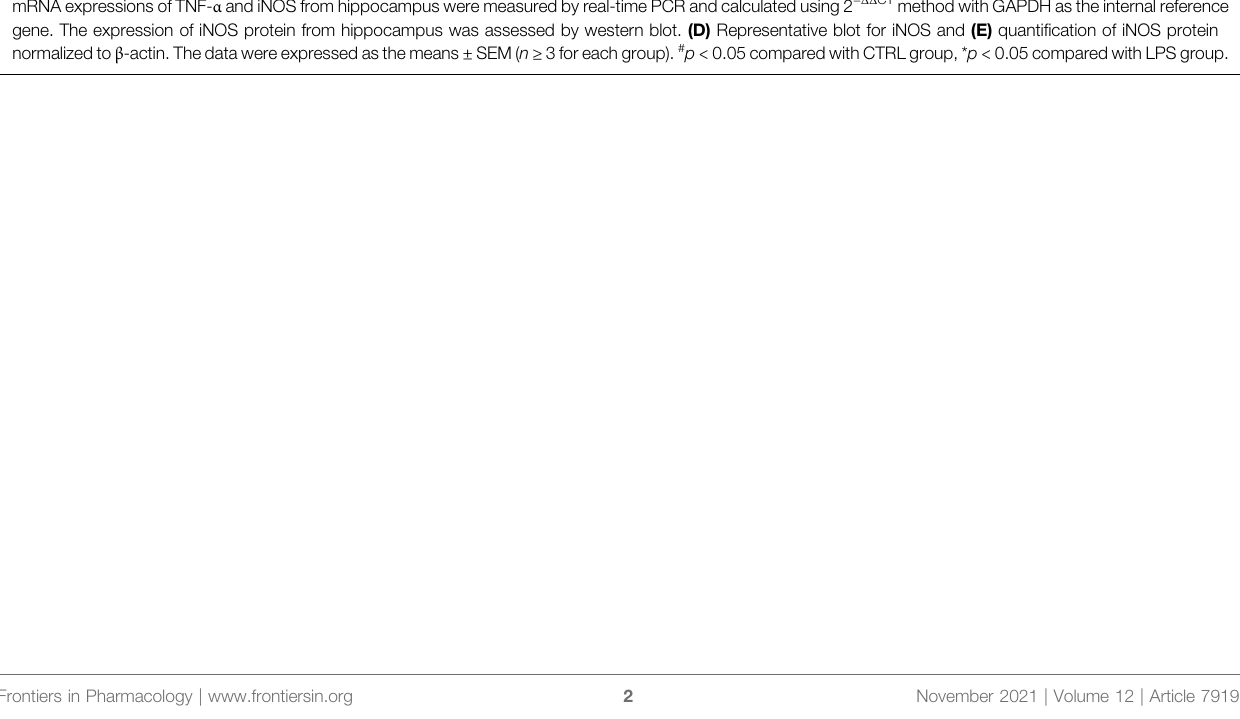
Frontiers in Pharmacology |